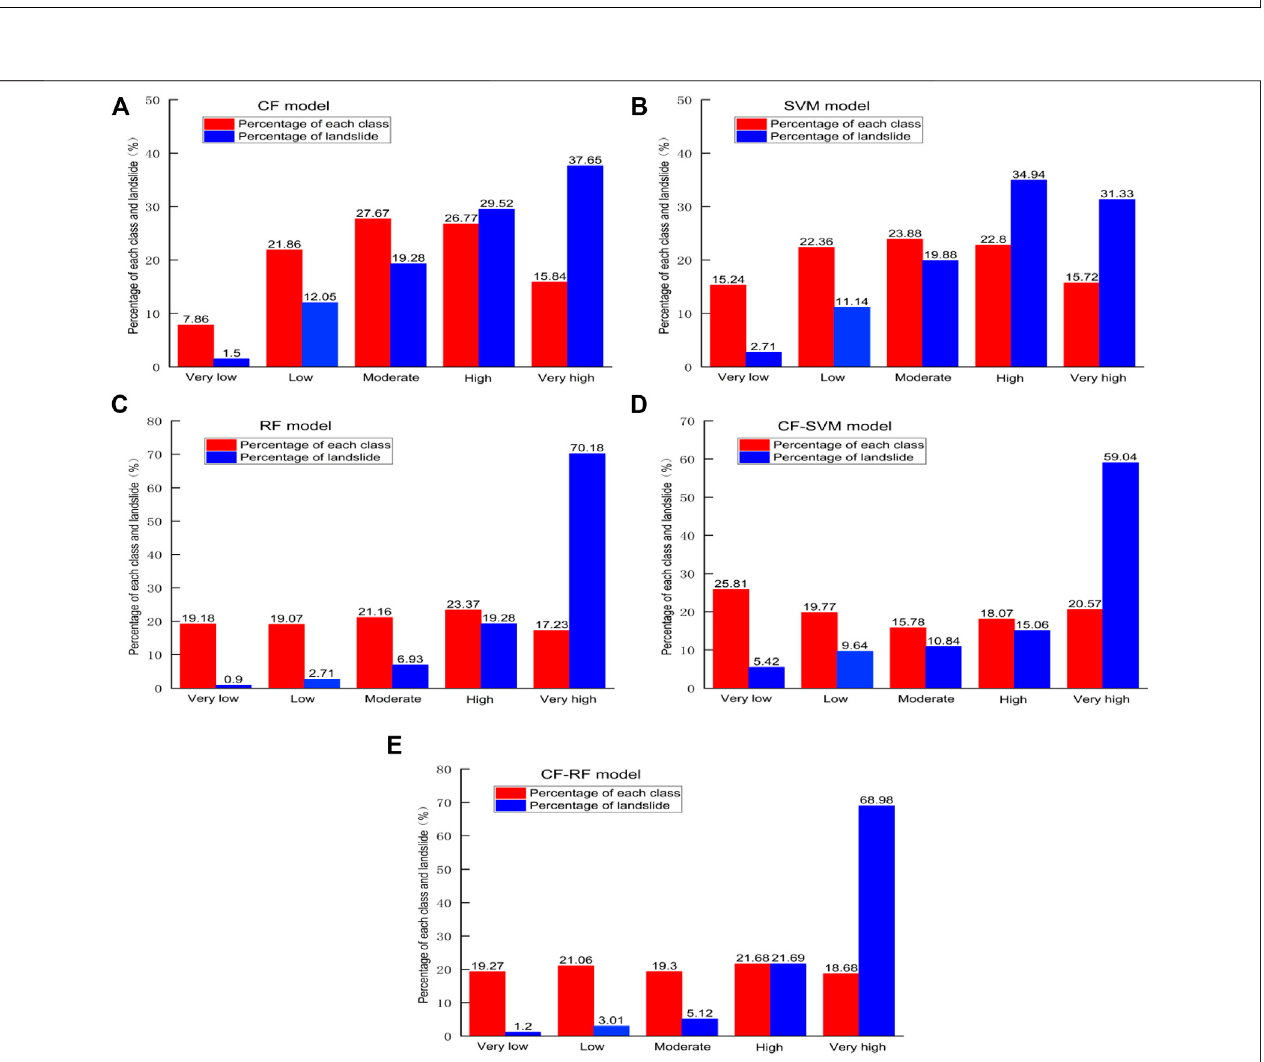
FIGURE 8 | Landslide susceptibility classes and the percentages of landslides as determined by the: (A) CF model, (B) SVM model, (C) RF model, (D) CF-SVM model and (E) CF-RF model.